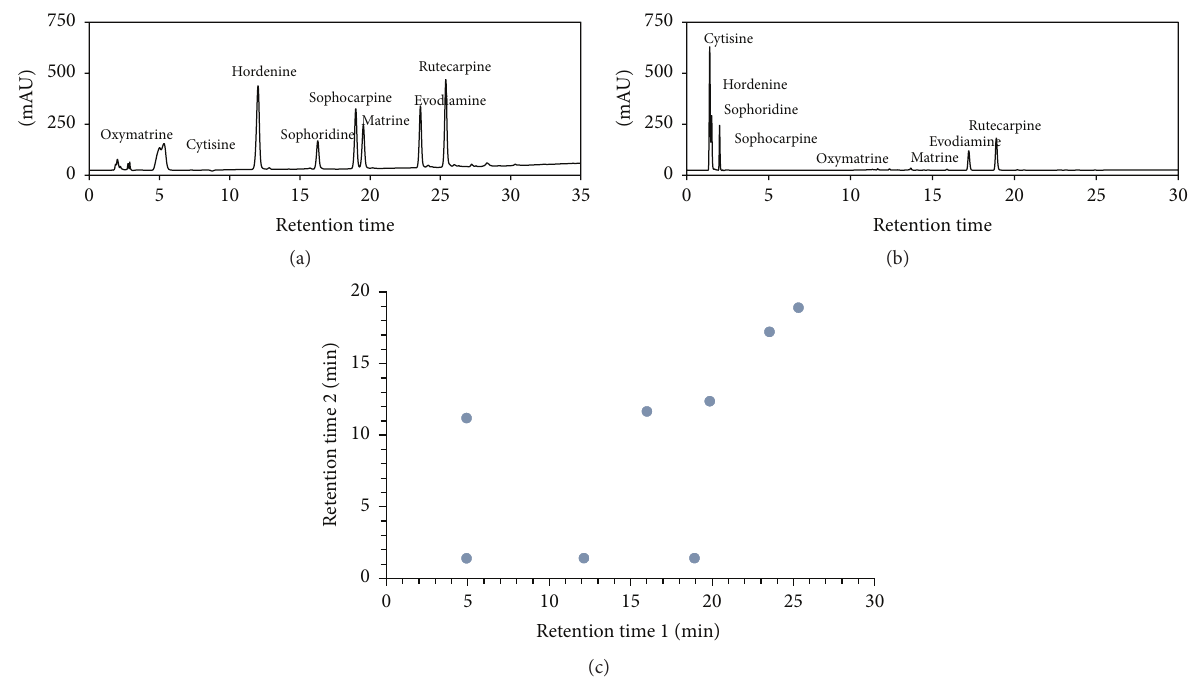
Figure 1: Analysis of alkaloid standards with different pH conditions. ((a) pH = 10.5; (b) pH = 3.0). (c) The scattering of alkaloid standards retention times with different pH conditions. The 𝑥 -axis denotes the separation under pH 3.0, and the 𝑦 -axis is the separation under pH 10.5. All chromatograms were recorded under 280 nm using a photodiode array